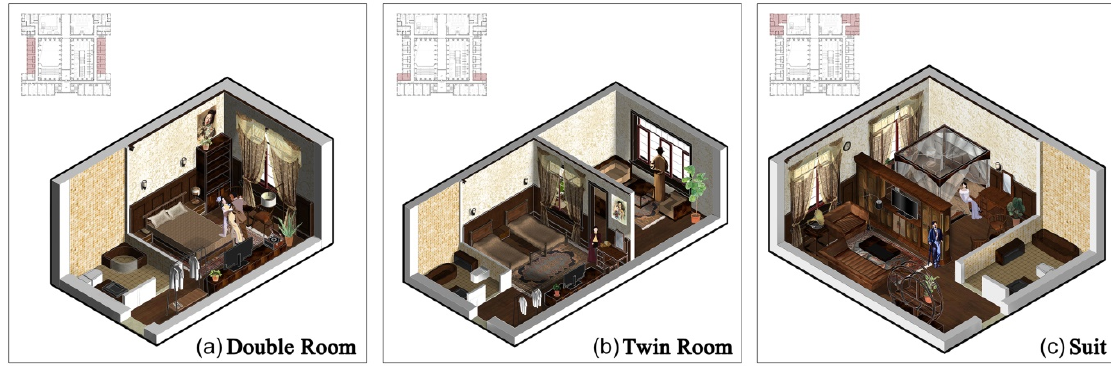
Figure 22. Adaptive Analysis of Unit Space as Hotel